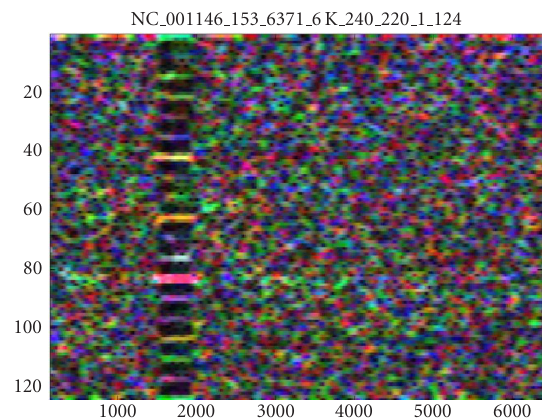
Figure 20: Spectrogram of the YRF1-6 gene. The bar region cor- responds to a highly conserved domain in Y (cid:1) -helicase subtelomeric open reading frames.